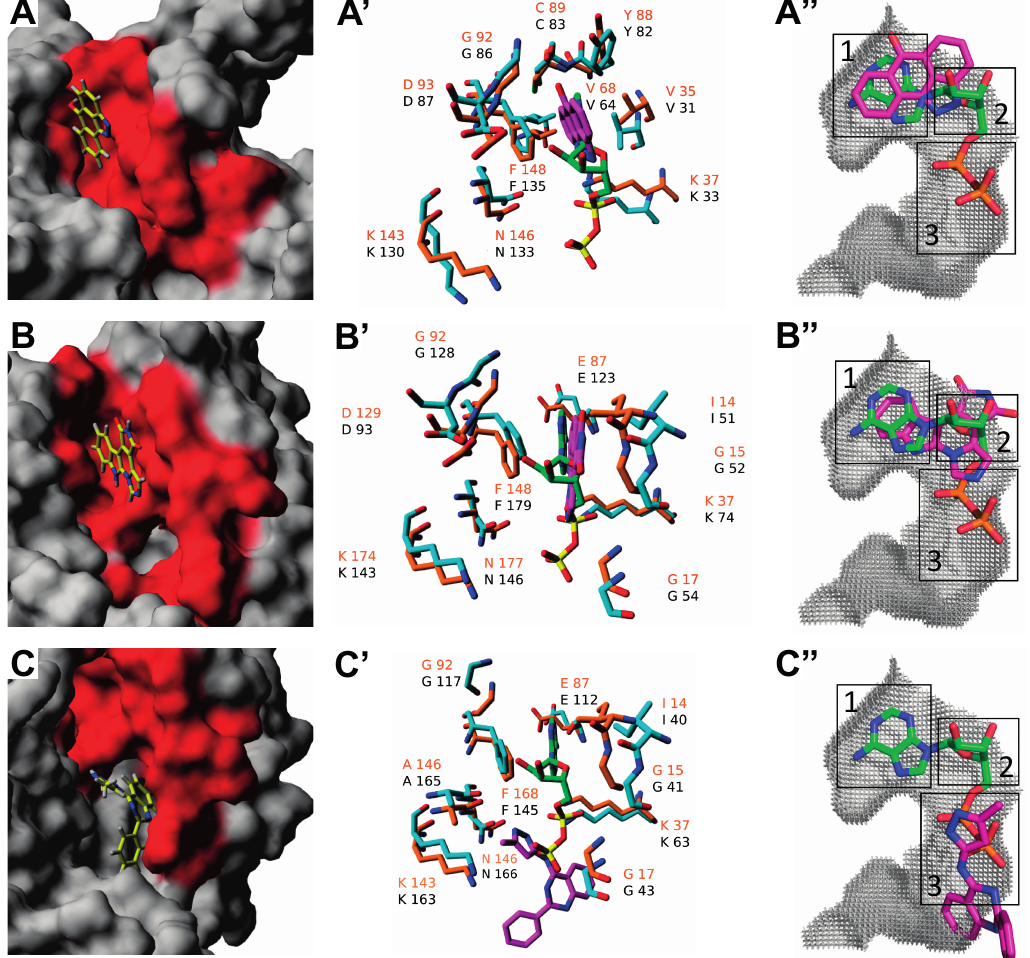
Figure 1. Representationofbestcandidate compounds complexed to recombinant hNeks 1, 6, and 7 in comparison withhNek2 in the ATP-binding site. ( A – C ) Three-dimensional representation of the top docking position for each compound-target complex in the ATP-binding site (red). ( A’ – C’ ) Three-dimensional representation of the interactions between each target protein (cyan) and candidate compound (magenta) in comparison to our reference hNek2 (PDB: 2W5A) (orange) boundto ADP (green). Amino acid residue labels are depicted in orange for the reference hNek2 and in black for the other hNeks. ( A” – C” ) Three-dimensional representation of the preferable area occupied by candidate compounds (magenta) relative to ADP (green) in the ATP-binding site cavity (grey) of our reference hNek2 (PDB: 2W5A) identified by KV Finder. The binding subsites are depicted as follows: (1) adenine region; (2) ribose region; and (3) phosphate groups region. (A) hNek1( Δ 262-1258)-(T162A) bound to JNK Inhibitor II; (B) hNek6(S206A) bound to Isogranulatimide; (C) hNek7wt bound to GSK-3 Inhibitor